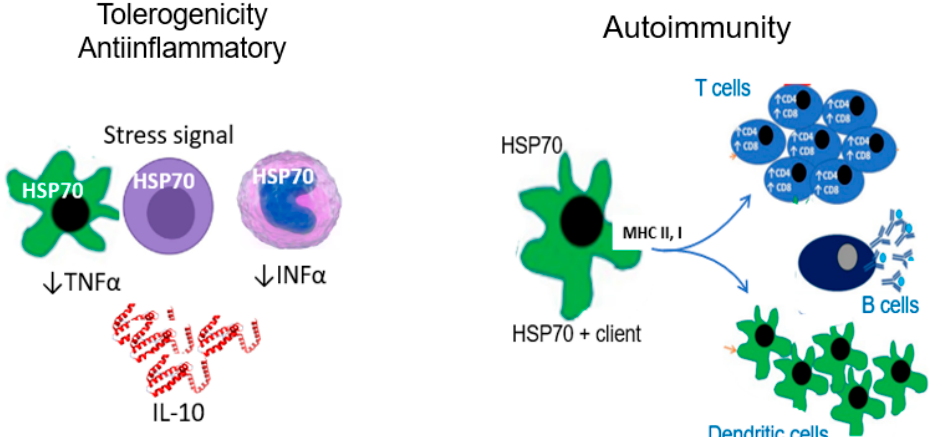
Figure 1. Immune reactivity induced by HSP70. HSP70 response to stress may induce tolerogenic anti-inflammatory responses as well as immune reactivity. Intracellular HSP70 activation suppresses NLRP3 inflammasome activation. In addition, specific polypeptide sequences of HSP70 induce a tolerogenic responses characterized by IL-10 immunomodulatory secretion. In contrast, extracellular HSP70 induce immune reactivity that includes anti-HSP70 antibody formation. The chaperoning function of HSP70 include the protection and transfer of exogenous and endogenous antigenic peptides to the MHC I and II and the subsequent adaptive immune reactivity. Tolerogenic responses to intracellular HSP70 in dendritic cells and macrophages include reduction of TNF α and INF α and production of IL-10 by T cells. Suppression of T cell-induced inflammatory responses is independent of its effects on monocyte-derived immature dendritic cells [17].